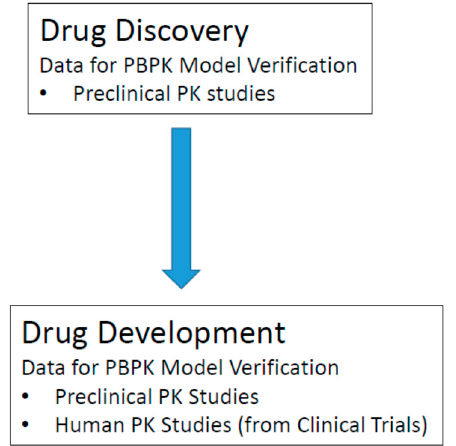
Figure 6. Sources of PK data required for model verification.